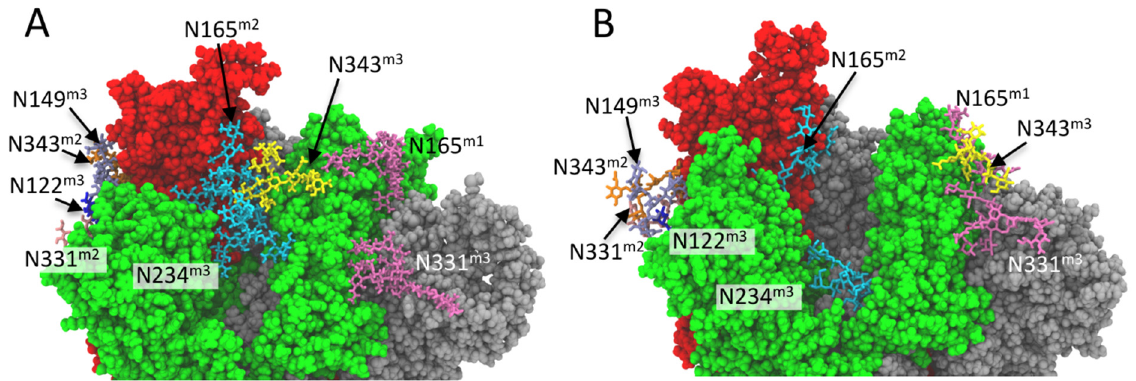
Figure 7. Interactions of N-glycans with RBD domain in up conformation (monomer 2, red color). Monomer colors as in Figure 1C. Enlargement of the region of glycan-glycan and glycan-protein interaction close to RBD of monomer 2 in “up” conformation of the ( A ) Delta(representative frame at 783.8 ns of MD simulation)and ( B ) Omicron variant (representative frame at 893.3 ns of MD simulation), respectively. The amino acids are represented in the CPK model and the glycans (without hydrogen atoms) are represented in licorice. For each residue, the monomer to which they belong is reported as superscript.